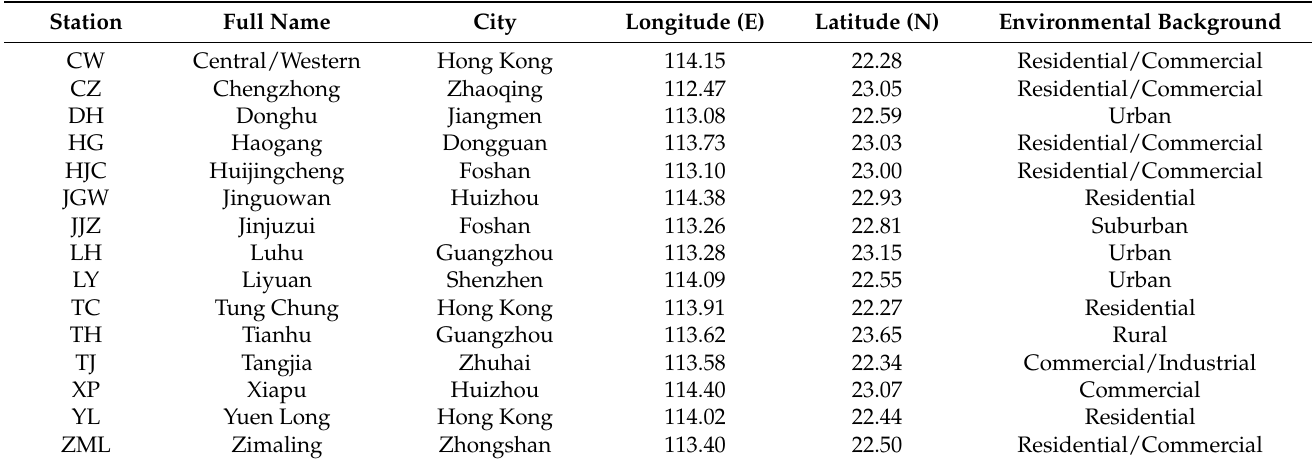
Table 1. Location of fifteen O 3 monitoring stations across the Pearl River Delta and their environmental